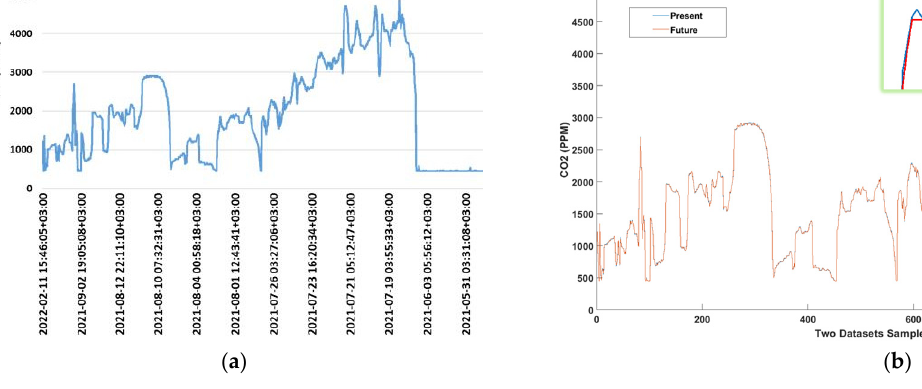
Figure 16. SeReNo V2 Deployment in QU to utilize the iterative OBRM3 optimization for P Infection-Present and P Infection-Future : ( a ) The forecasted CO2 data by OBRM3 for the years 2021–22 and ( b ) The P Infection-Present and P Infection-Future from Equations (24) and (25) for Y t-CO2 and Y t-T for I µ using